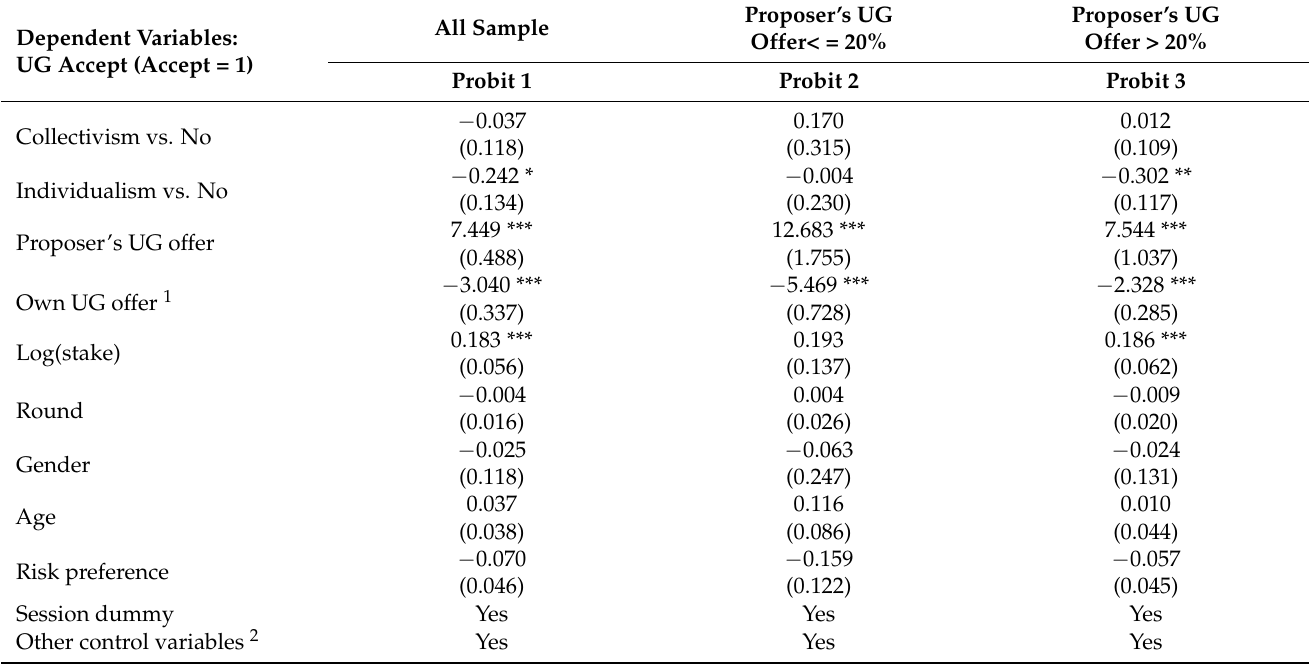
Table 5. Regression analysis of three treatments of responders’